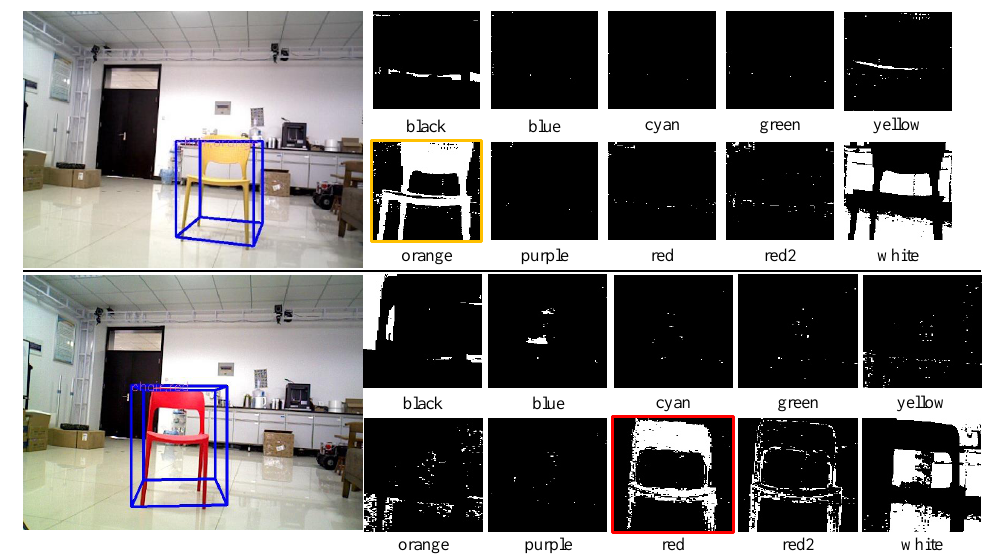
Figure 6. Experimental results of 3D object detection with embedded color attributes. The top and bottom columns represent the color feature extraction for orange and red chairs, respectively.